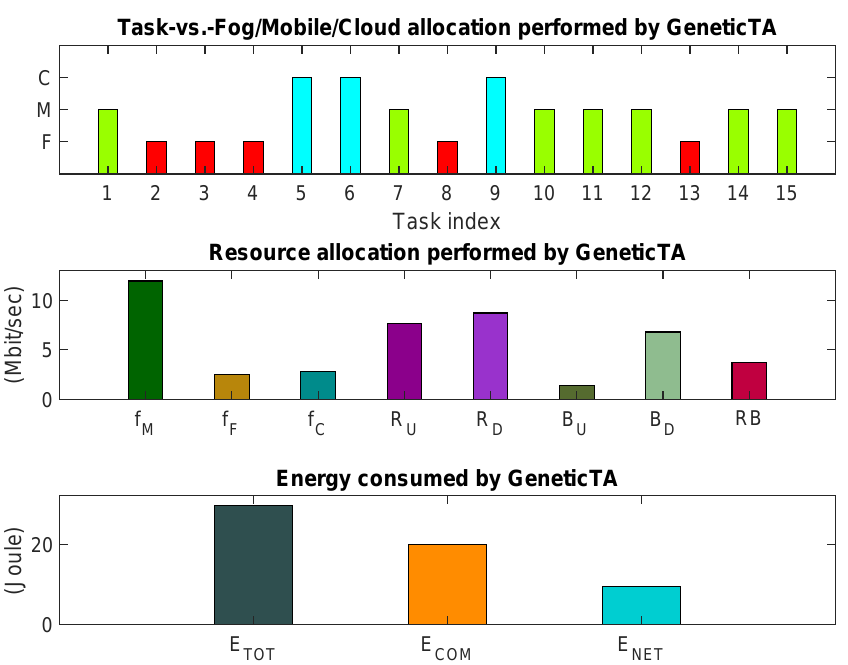
Figure 3. An illustrative screen-shoot of the bar-plots rendered by the execution of the GeneticTA_par function. ( top ) reported task allocation; ( middle ) reported resource allocation; ( bottom ) consumed total and network energies. Analogous bar-plot graphs are reported at the end of the executions of the other task allocation strategies supported by VirtFogSim